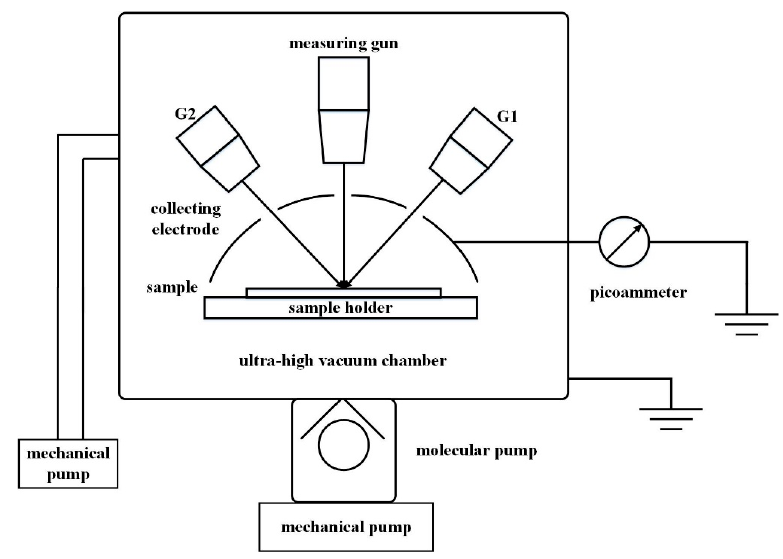
Figure 1. Schematic diagram of secondary electron yield measurement.